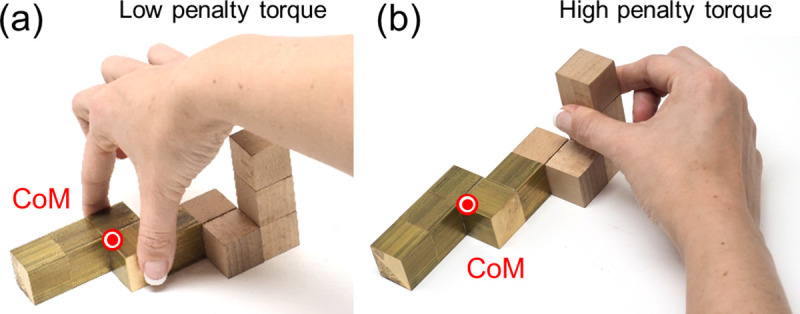
Torque.Examples of grasps with (a) low penalty and (b) high penalty torque.